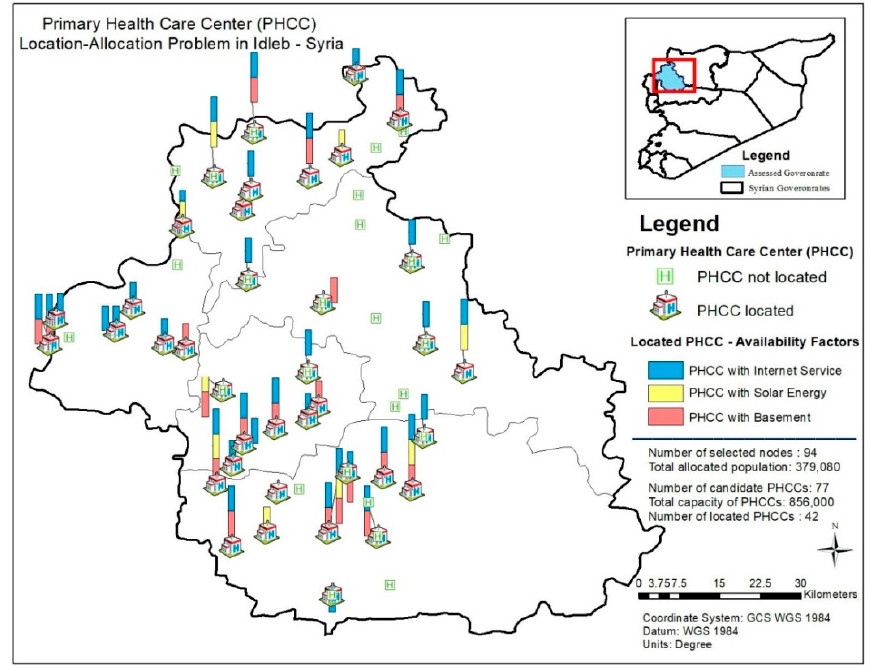
Figure 6. Availability of internet service, solar power and basement for the located PHCCs.